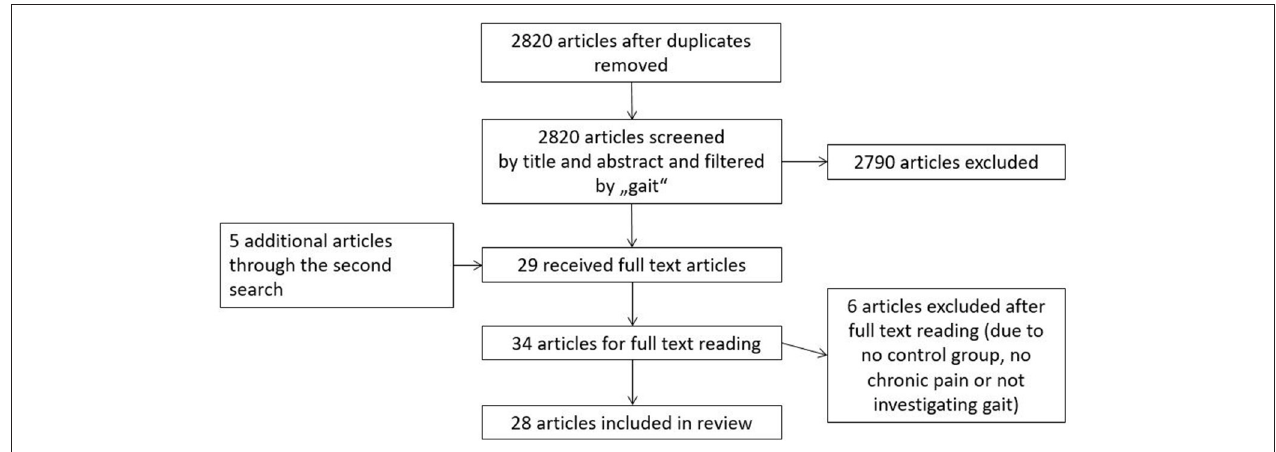
FIGURE 1 | Presenting a flow chart of search strategy and study